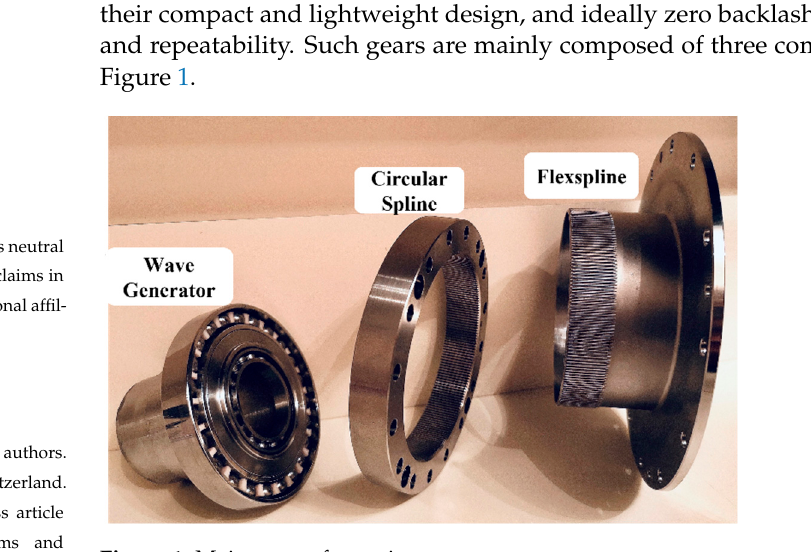
Figure 1. Main parts of a strain wave gear. The wave generator (WG) is a flexible elliptical ball or roller bearing which, once inserted inside the flexspline (FS), a flexible gear with external toothing, elastically